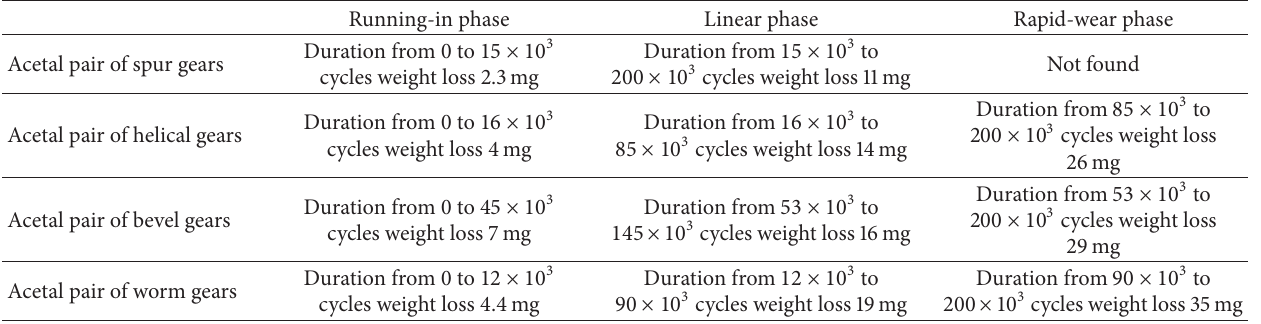
Table 6: The wear phases for different types of polymer